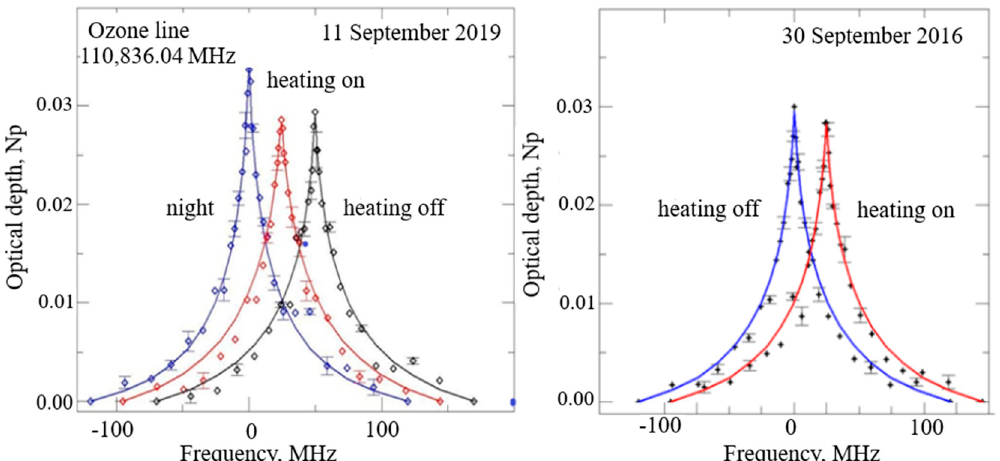
Figure 1. Modification of the ozone spectrum during artificial disturbance of the ionosphere for one of the heating sessions in 11 September 2019 ( left panel) and 30 September 2019 ( right panel). On the left panel red and black circles show the spectrum values during the heating and pause sessions. Blue circles refer to nighttime ozone spectrum measurements. Solid curves (red, blue and black) on the left panel show the spectra calculated using the vertical ozone distributions. On the right panel red and blue lines show ozone spectrum measured during the heating and pause sessions respectively.